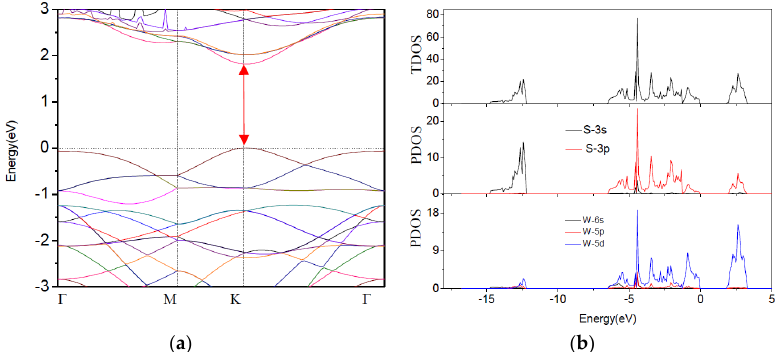
Figure 2. ( a ) Band structure of pure monolayer WS 2 and ( b ) TDOS and PDOS of pure monolayer WS 2 . The band gap are shown with red arrows.